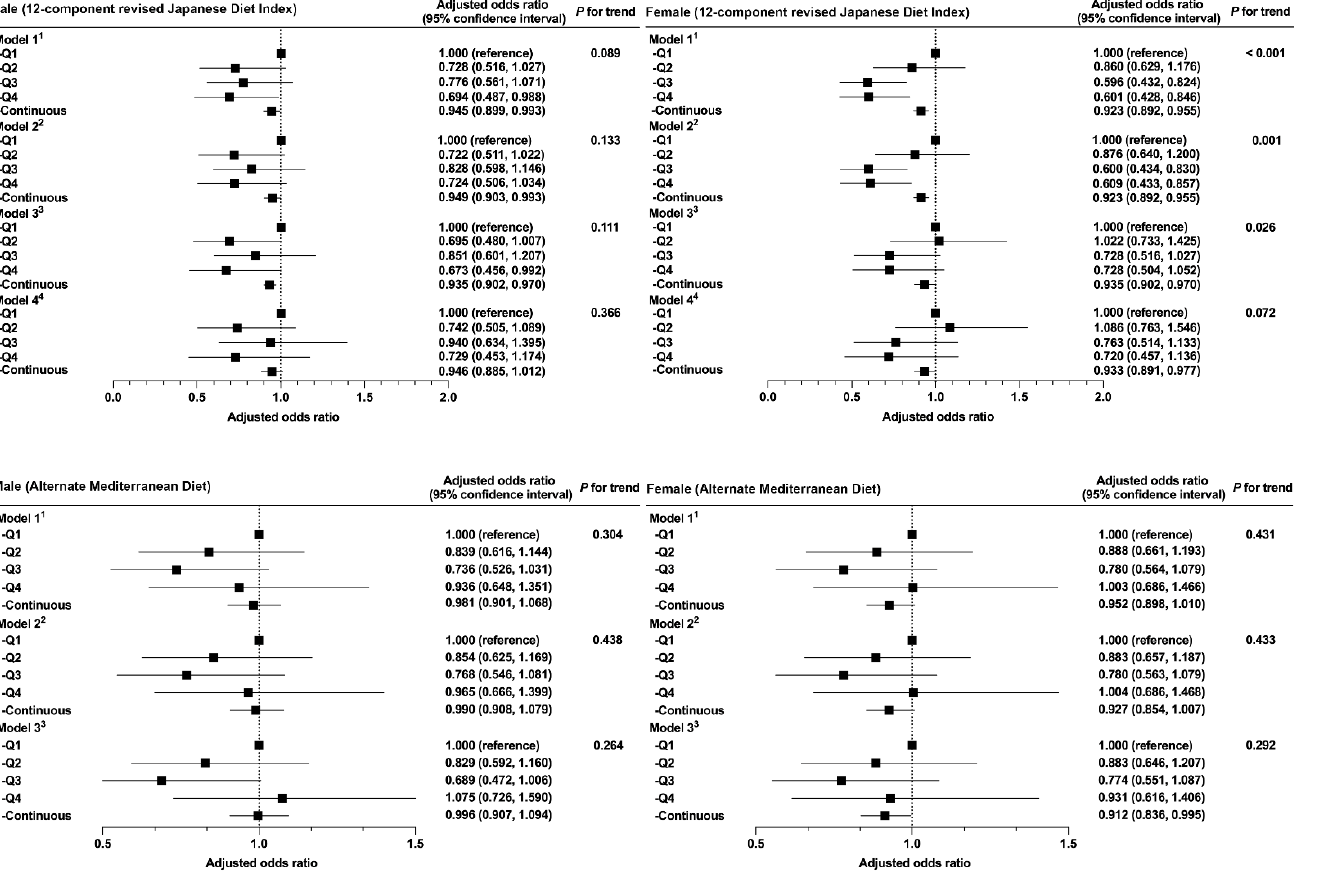
Figure 3. Relationship between the two dietary patterns and muscle weakness, stratified by sex. 1 Model 1 was adjusted for age (50–54, 55–59, 60–64, 65–69, or ≥70 y). 2 Model 2 was adjusted for Model 1 plus BMI (<18.5, 18.5–25, ≥25 kg/m2, or missing). 3 Model 3 was adjusted for Model 2 plus IADL score (TMIG-IC score), time spent walking (≥1, 0.5–1, <0.5 h/d, or missing), alcohol consumption (every day, sometimes, never, or missing), smoking status (current, former, never, or missing), and history of diseases (cerebrovascular disease, coronary heart disease, diabetes, cancer (yes, no, or missing for each term)). 4 Model 4 was adjusted for Model 3 plus energy intake (kcal/d; sex-specific quintile categories). Continuous variables were entered into each model as continuous values for each dietary score.